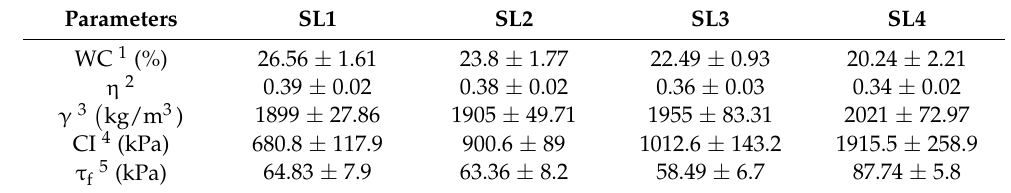
Table 6. Results of measurement of soil properties according to soil layers in clay loam (third site).